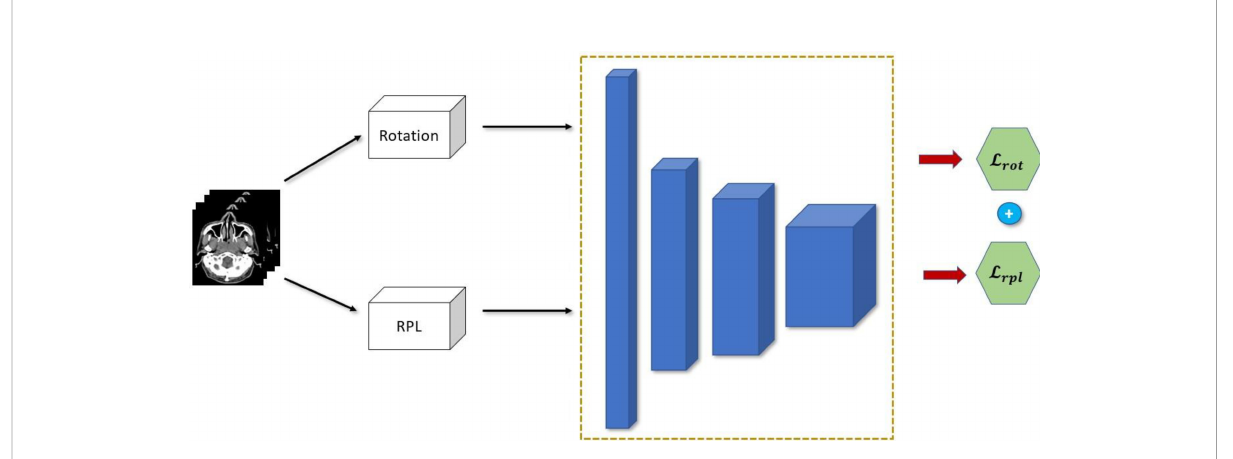
FIGURE 4 Proposed combination of semi-supervised learning pre-text